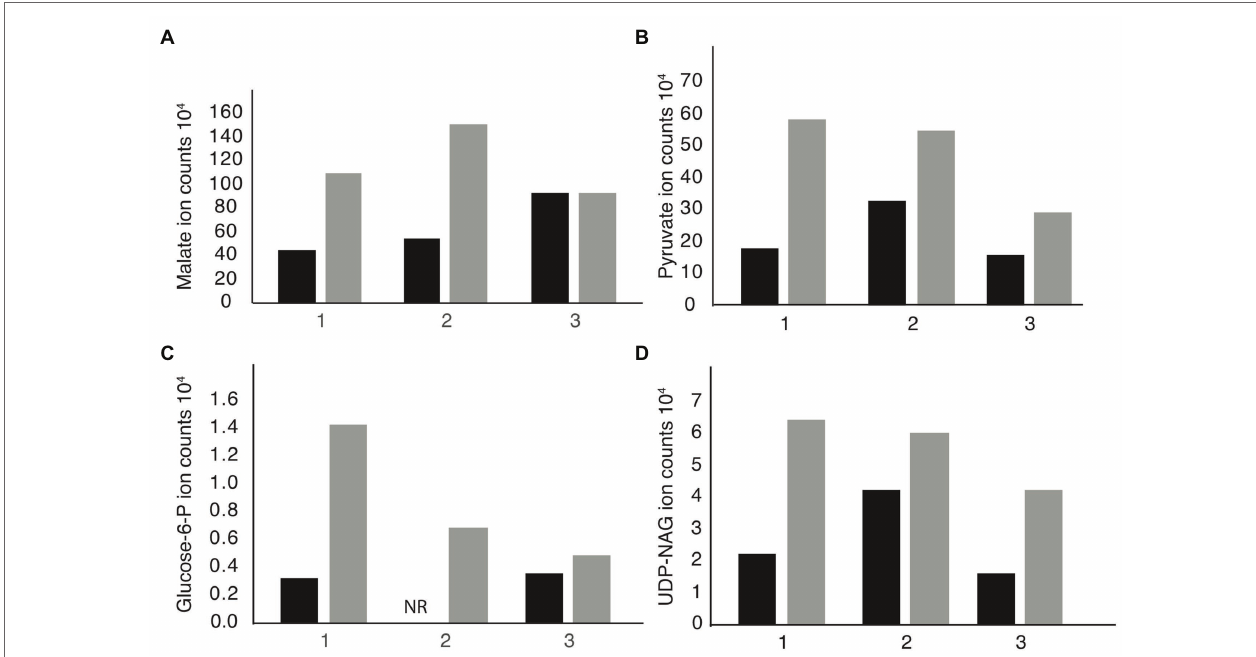
FIGURE 3 | Metabolomics analysis reveals upregulation of gluconeogenesis in mdh cells. Cells were grown in LB medium without the addition of sugar on three independent cultures. The individual ion counts from each day were analyzed to ensure a consistent pattern. (A) Ion counts of malate levels in WT and mdh cells. (B) Ion counts of pyruvate levels in WT and mdh cells. (C) Ion counts of glucose-6P levels in WT and mdh cells. NR, not recorded. (D) Ion counts of uridine diphosphate N-acetylglucosamine (UDP-NAG) levels in WT and mdh cells. Black bars – WT cells, gray bars – mdh